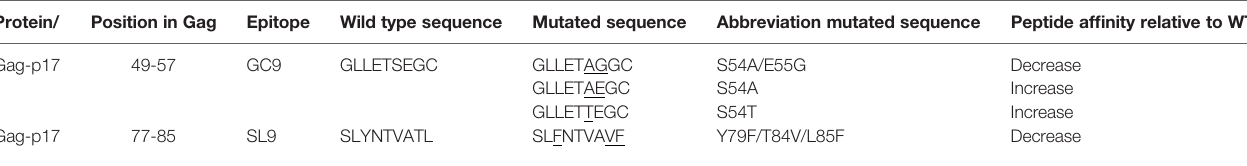
TABLE 1 | List of the wild type and mutated GC9 and SL9 epitopes. Protein/ Position in Gag Epitope Wild type sequence Mutated sequence Abbreviation mutated